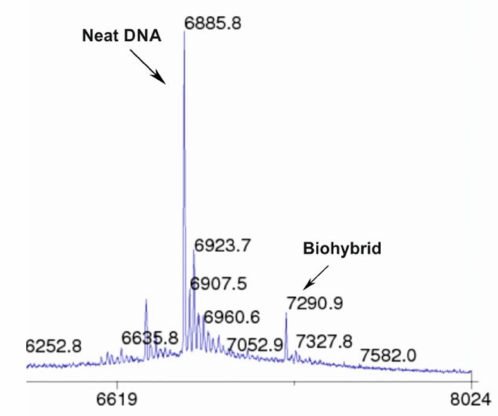
Figure 5. The part of the MALDI–MS spectrum of negative ions showing the mother peak for the neat parent nicked decamer, at m / z = 6885.8 ([M − H] − ), and a peak of the biohybrid of 2 with decamer 1 at m / z = 7290.9. The difference in masses M = 405 is due to transient intermediate o -methylene quinone formed from parent compound 2 or 3